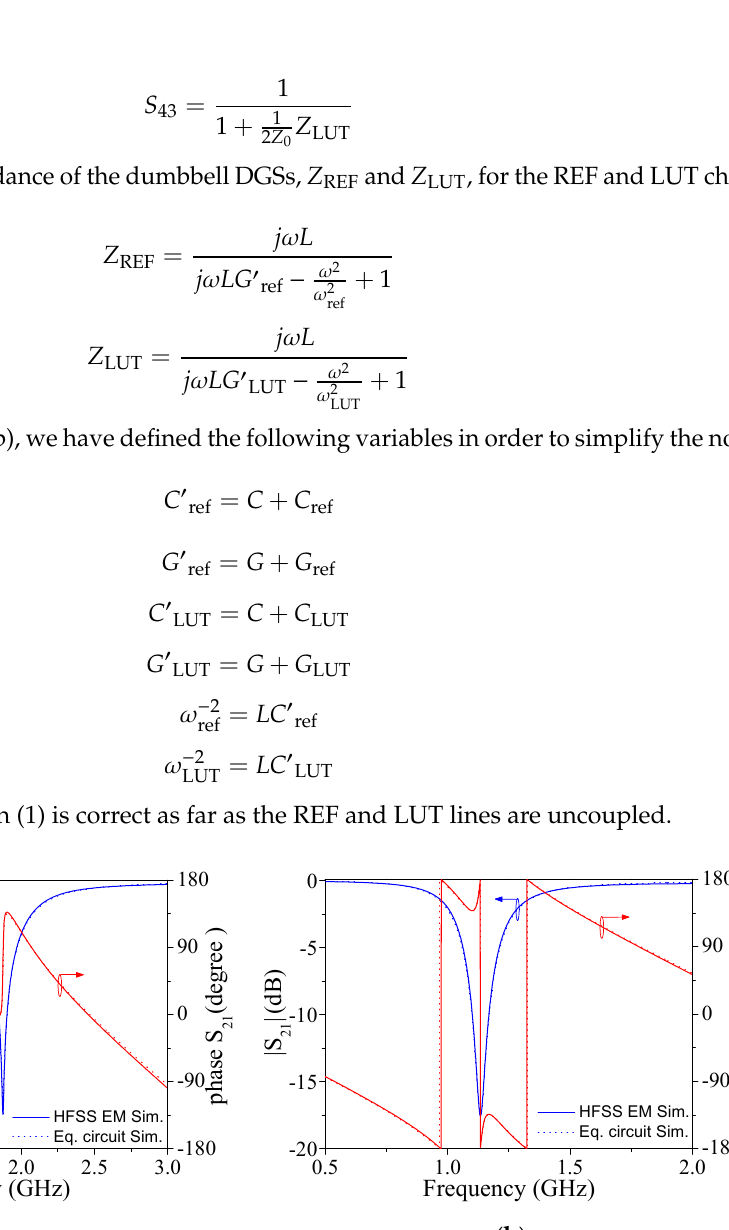
Figure 2. Equivalent circuit model of the proposed sensor.